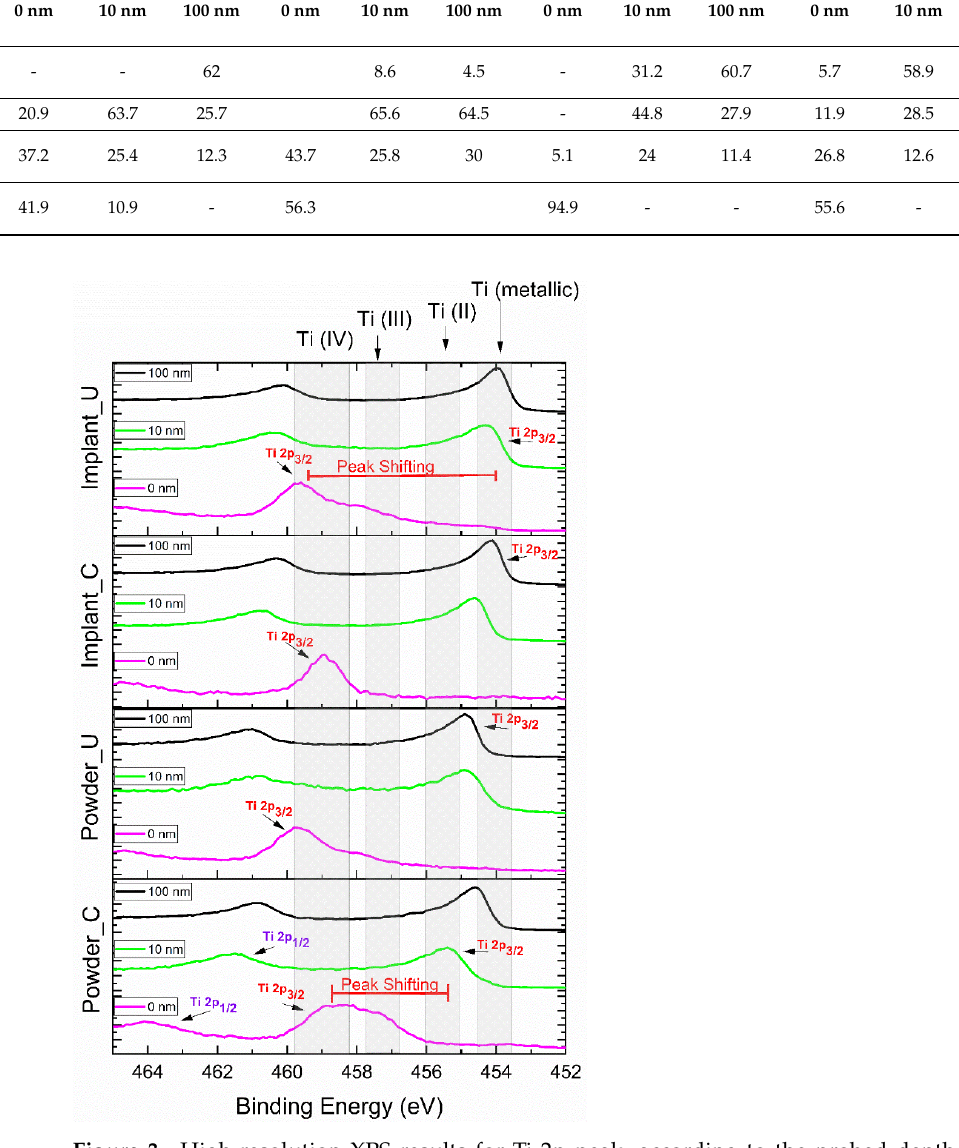
Figure 3. High-resolution XPS results for Ti 2p peak, according to the probed depth. Ti 2p is composed of two spin-orbit peaks: Ti 2p3/2 and Ti 2p1/2. The Ti 2p3/2 peak sifting from 0 nm to other experimental conditions was